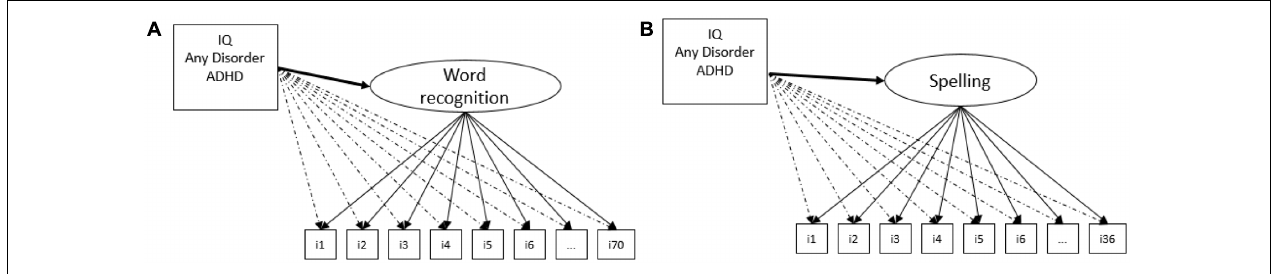
FIGURE 1 | Multiple Causes (MIMIC) model for the word recognition (A) and spelling tasks (B) , illustrating the effects of the covariates on the general factor underlying the word recognition and spelling tasks (population heterogeneity) and the DIF test for the items (dashed lines from the covariates to the items).